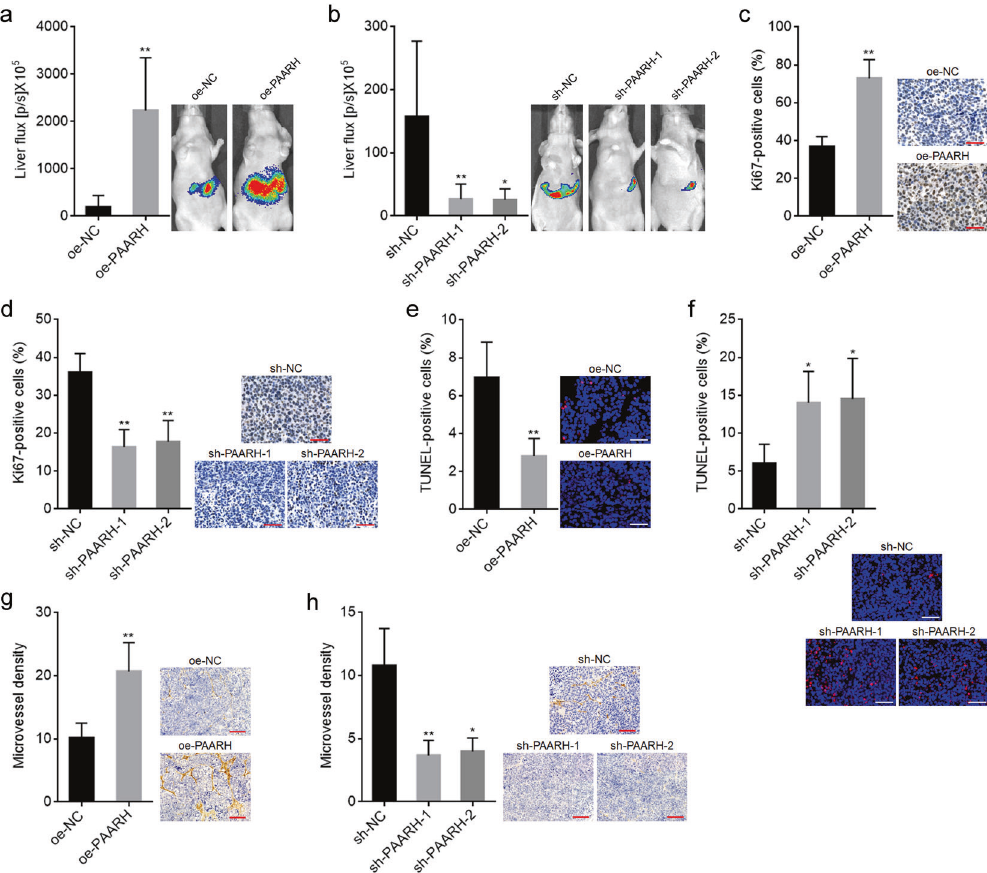
control. Scale bars, 50 µm. d Ki67 IHC staining of liver tumors formed by SNU-398 cells with PAARH stable silencing or control. Scale bars, 50 µm. e TUNEL staining of liver tumors formed by SNU-398 cells with PAARH stable overexpression or control. Scale bars, 50 µm. f